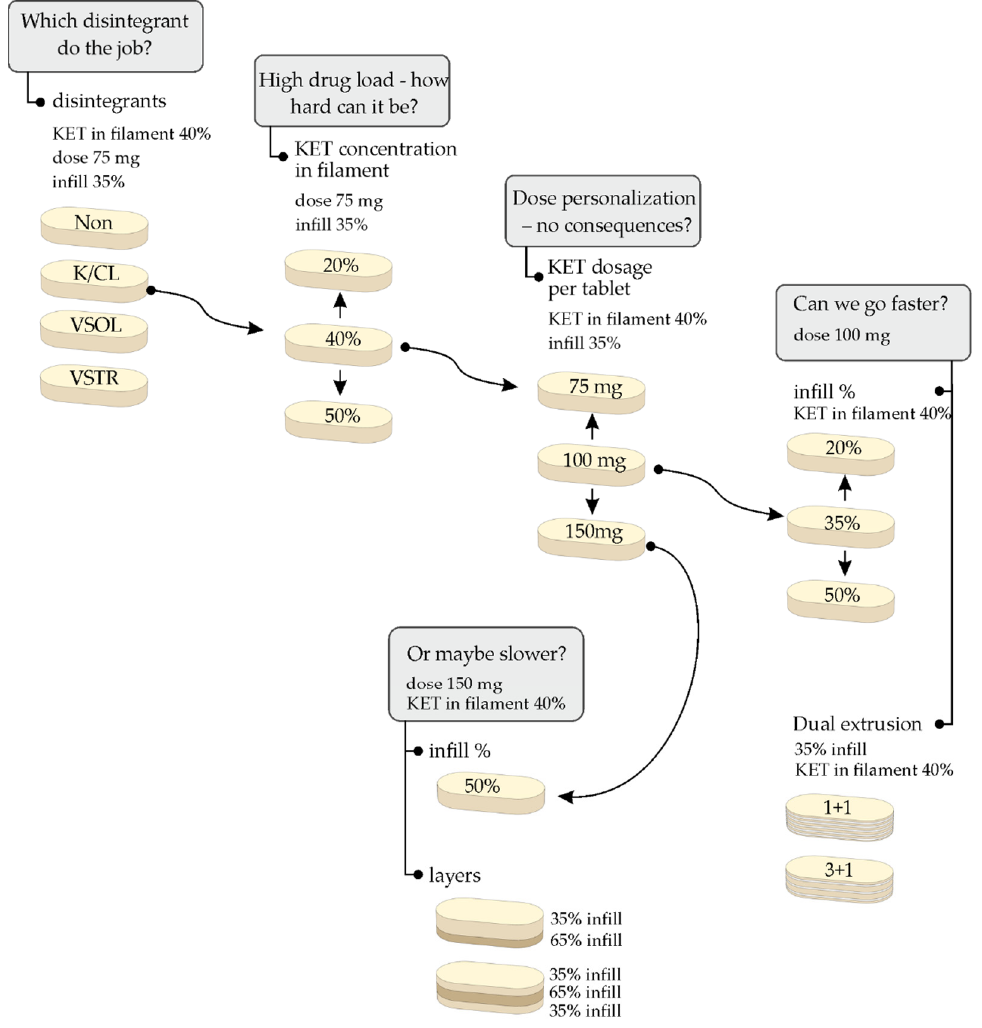
Figure 1. Schematic representation of the design of performed 3D printing experiments.